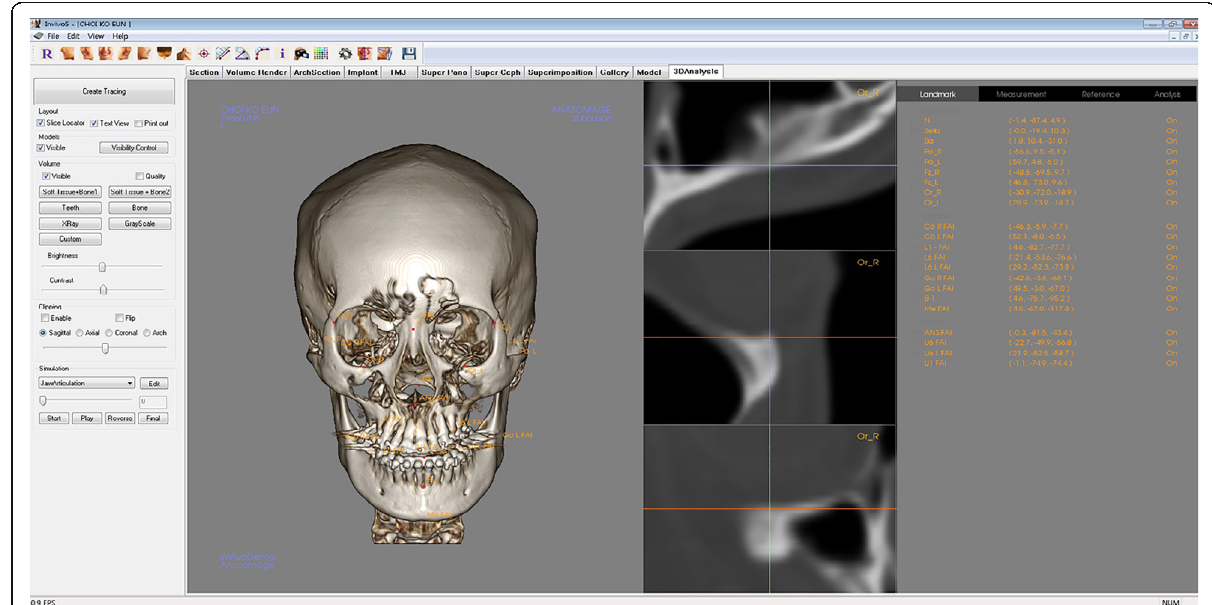
Fig. 1 The x , y , z coordinate data of 5 reference landmarks — nasion, sella, midpoint of both Z points, frontozygomatic suture point, and porion — and 10 measurement landmarks were obtained by using 3D simulation